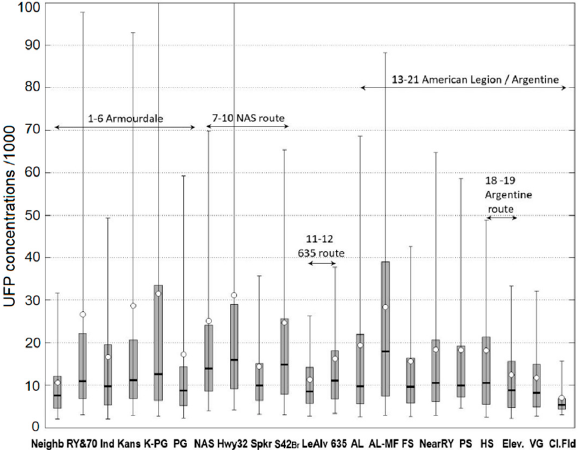
Figure 4. Comparison of distributions of observed BC concentrations at six stationary sites and at selected mobile monitoring areas representing concentrations around the six stationary sites.